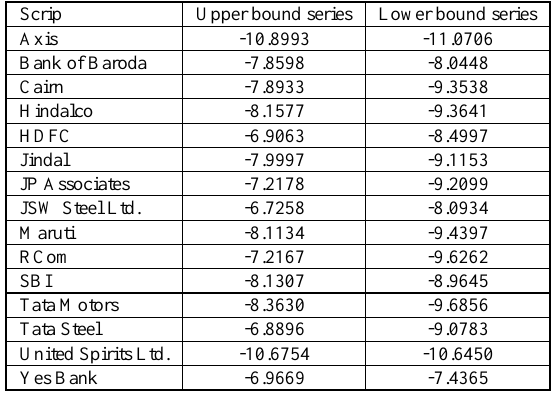
Table 2. Augmented Dickey Fuller Test statistics for daily high and low